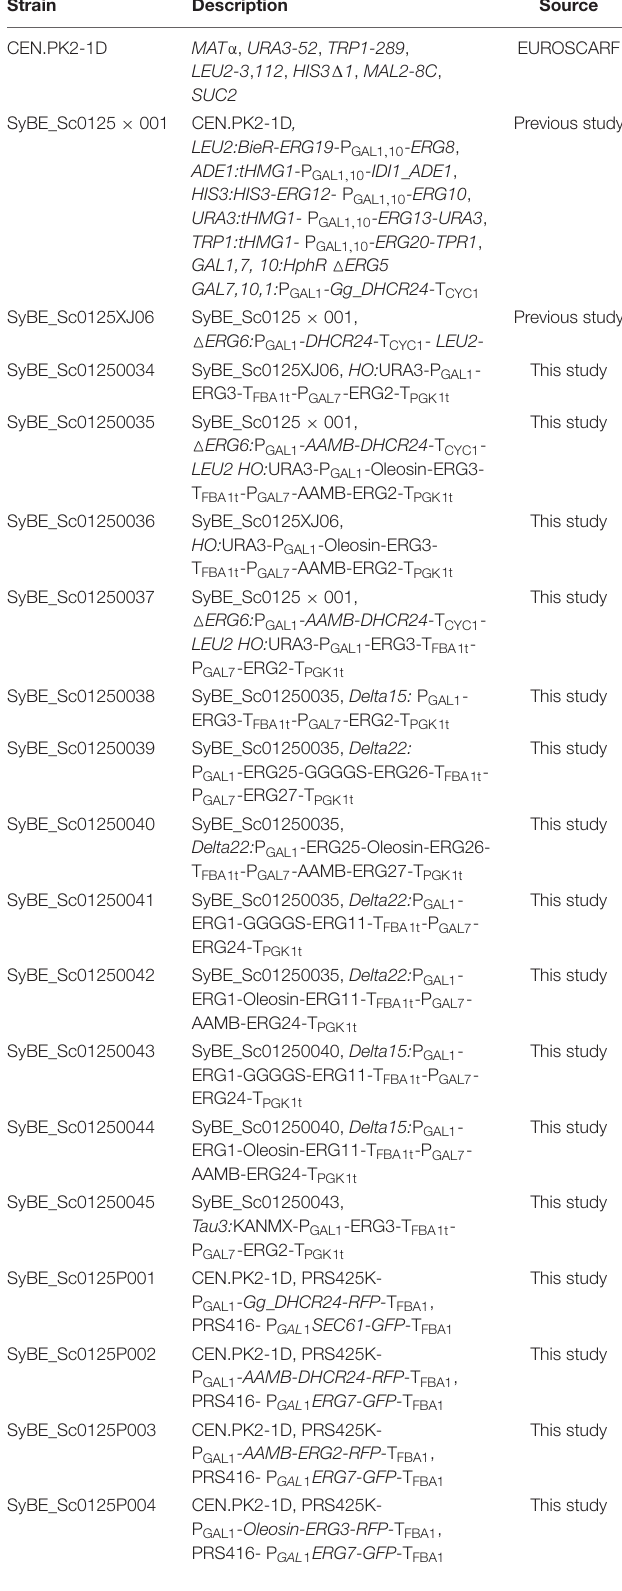
TABLE 1 | Saccharomyces cerevisiae strains used in this study. Strain